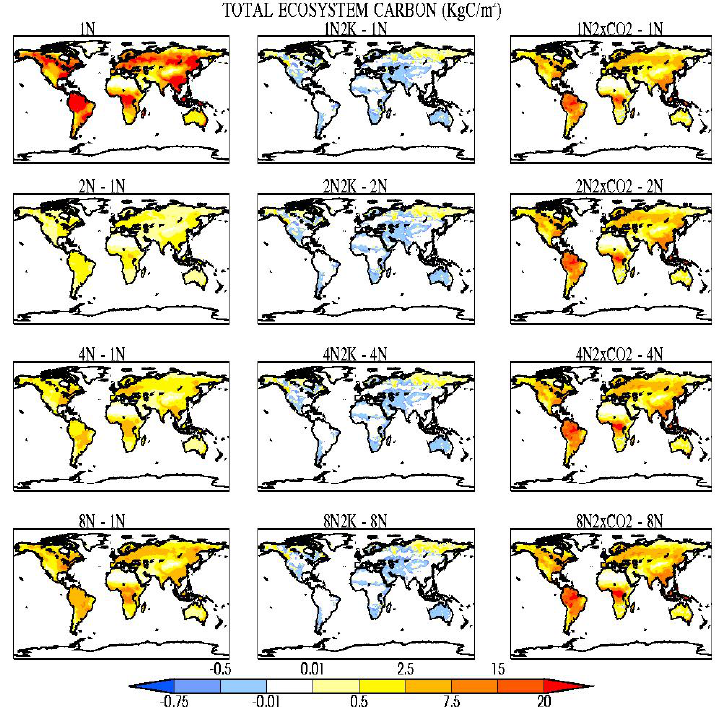
Fig. 4. Total ecosystem carbon (TEC) changes in the three sets of simulations. Left panels show TEC changes for N deposition and middle and right panels show TEC changes for climate warming and CO 2 fertilization under different background N deposition, respectively. Fig. 5: Changes in N-budget for the terrestrial ecosystem in 2N (blue line), 4N (green line) and 8N (red line) simulations relative to 1N: Changes in annual mean (a) biological N fixation